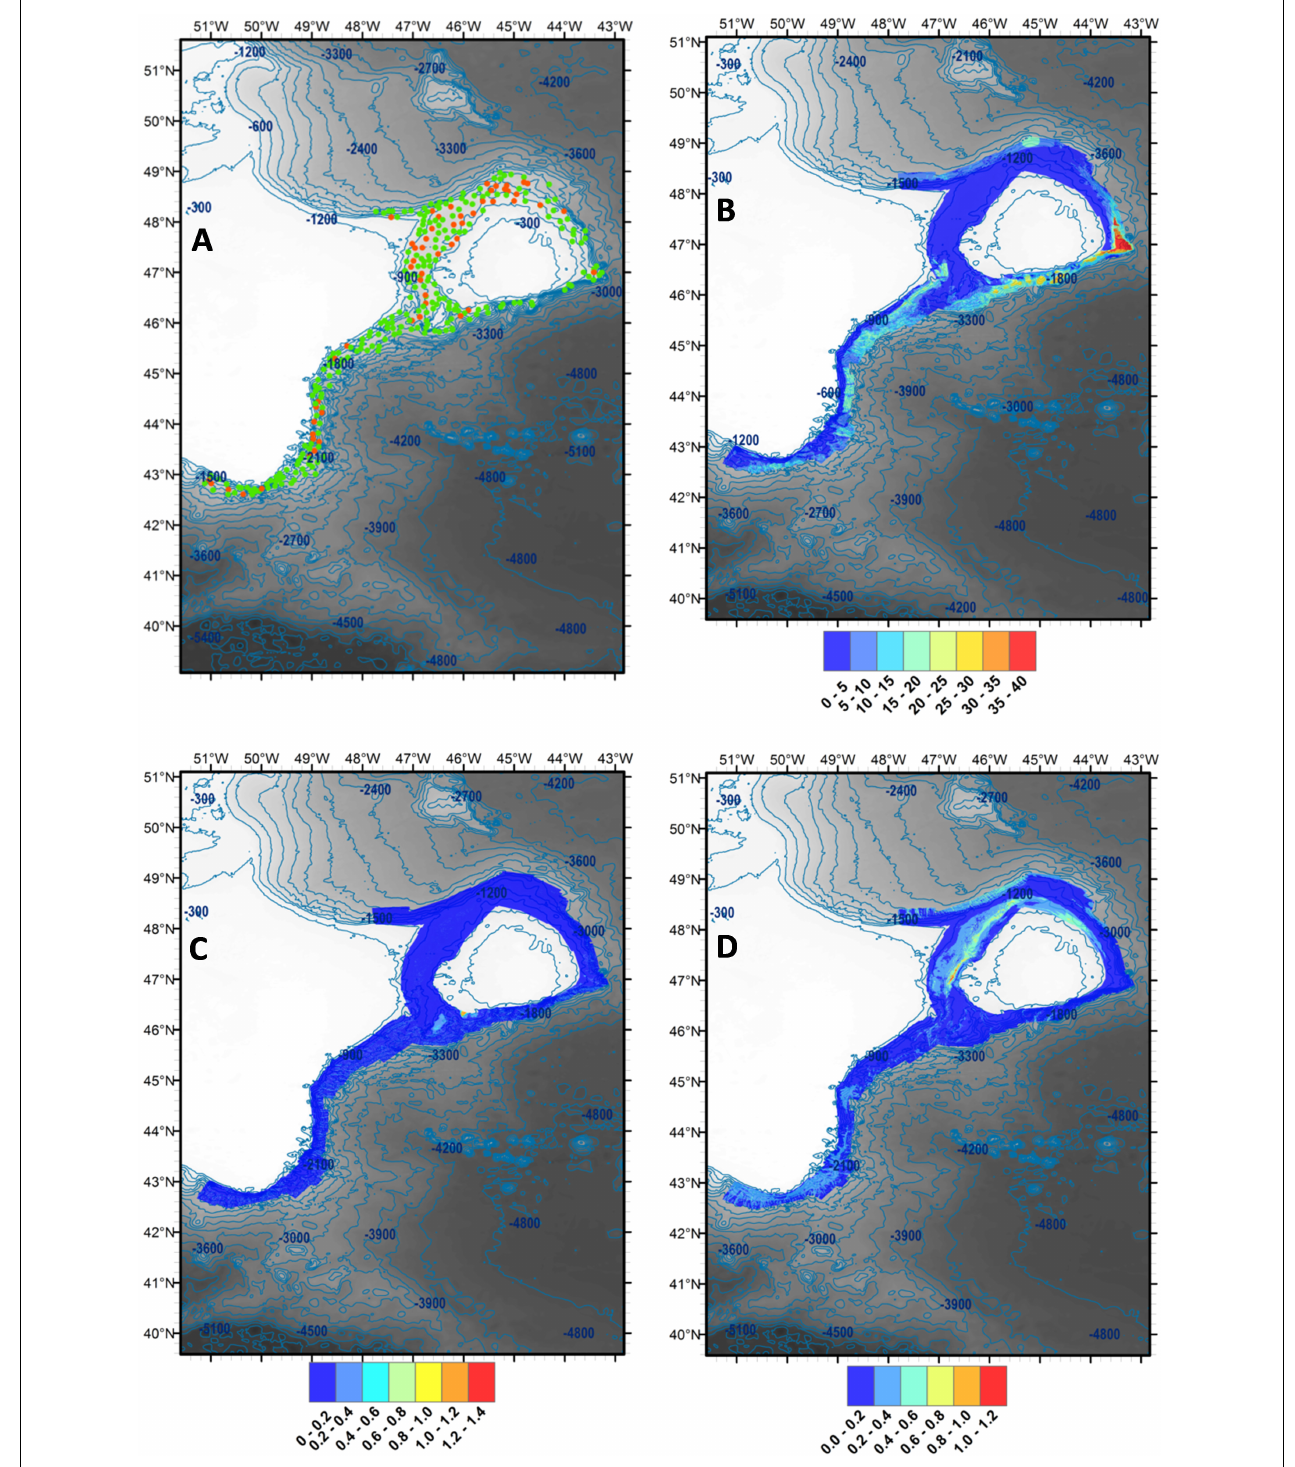
FIGURE 2 | (A) Presence (green)/absence (red) of siliceous poriferan spicules in samples collected as part of the NEREIDA programme. (B) Relative biomass of Porifera across the study area (high, red; low, blue), as determined by random forest regression modelling. (C) Relative biomass of gorgonian corals across the study area (high, red; low, blue), as determined by random forest regression modelling. (D) Relative biomass of Pennatulacea across the study area (high, red; low, blue), as determined by random forest regression modelling. Contours in metres. SRTM30 bathymetric data used (lighter, shallower; darker, deeper).